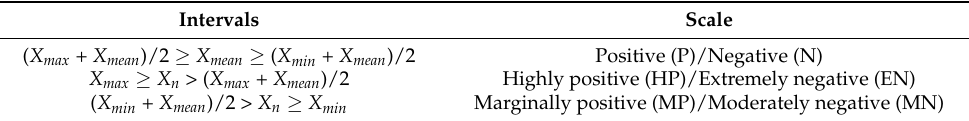
Table 5. X n intervals and effects on Y n